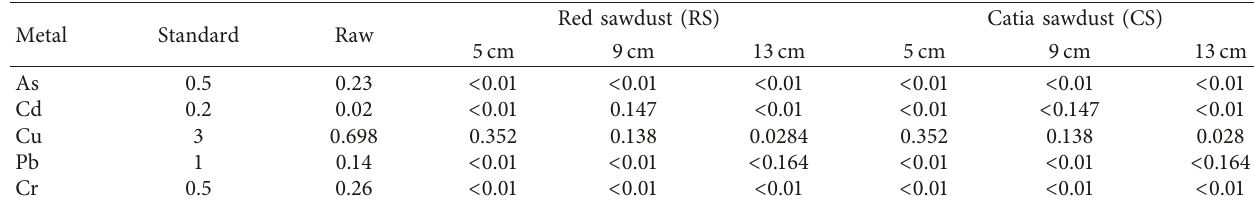
Table 3: Means concentration of heavy metals before and after treatment.